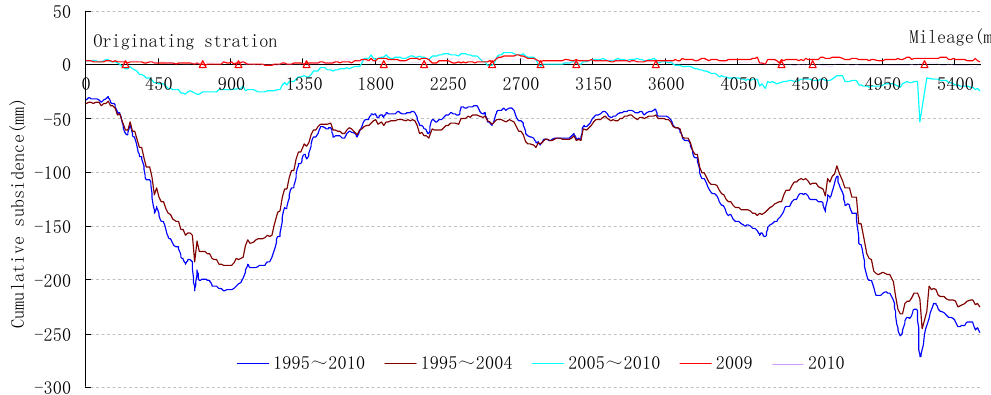
Figure 5. The cumulative subsidence curve of metro in each stage.